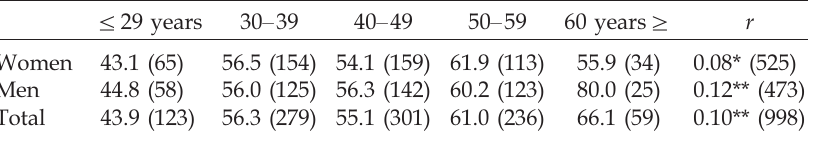
Table 2. Proportion with v ery good subjecti v e mastery of their job tasks by age and gender. Norwegian Senior Policy Barometer 2003. Percentage and Spearman r( N